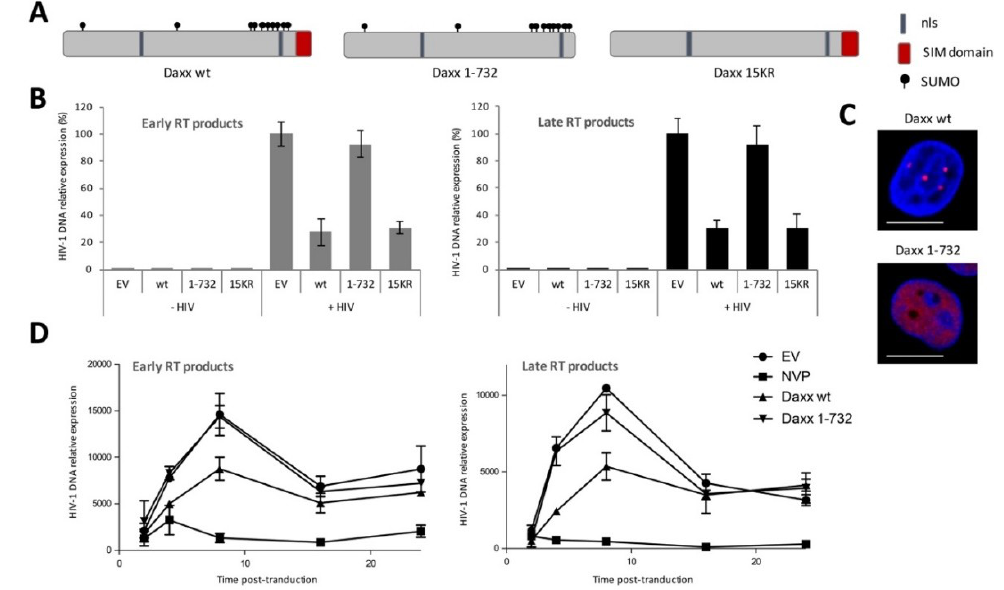
Figure 2. The inhibition of HIV-1 reverse transcription by Daxx requires its SUMO-interacting motif (SIM) domain. ( A ) Schematic representation of the Daxx wt protein and the 1-732 ( ∆ SIM) and 15KR mutants described in [44]; ( B ) HeLa cells were transfected with an empty vector (EV) or with plasmids encoding HA-tagged wt Daxx or 1-732 or 15KR Daxx mutants. Forty-eight hours post transfection, cells were transduced for 4 h with VSV-G pseudotyped HIV-1 at a MOI of 1, and early and late RT products were quantified by qPCR. The number of transcripts in the condition EV + HIV was arbitrarily set to 100%. Data represent the mean ± SD of one experiment performed in triplicate, representative of three independent experiments; ( C ) The expression of HA-tagged Daxx wt and 1-732 mutant was investigated by immunofluorescent confocal microscopy using anti-HA antibodies in HeLa cells. Scale bar = 2 µ m; ( D ) HEK293T cells were transfected with empty vector (EV) or with plasmids encoding Daxx (wt or 1-732). Twenty-four hours post transfection, cells were treated or not with nevirapine (NVP), as indicated, and transduced with VSV-G pseudotyped HIV-1 at a MOI of 1 for 2 to 24 h. Following DNA extraction, early and late HIV-1 RT products were quantified by qPCR. Data represent the mean ± SD of one experiment performed in triplicate, representative of two independent experiments.